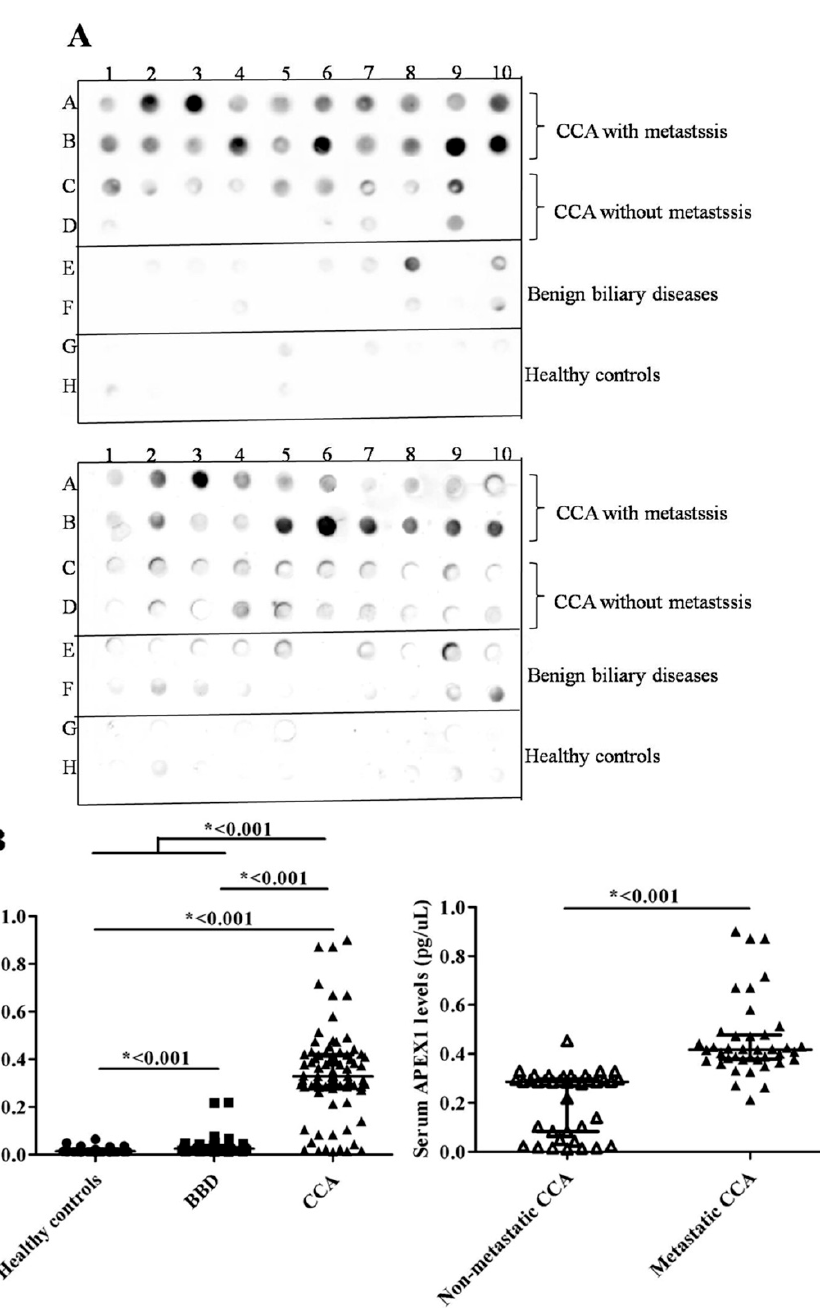
Figure 4. The validation of selected candidate protein, APEX1. ( A ) The result of dot blot. ( B ) The validation of serum APEX1 level as the biomarker using a dot blot assay. Long horizontal line: median value; short upper and lower lines: interquartile range. *: Statistically significant difference.